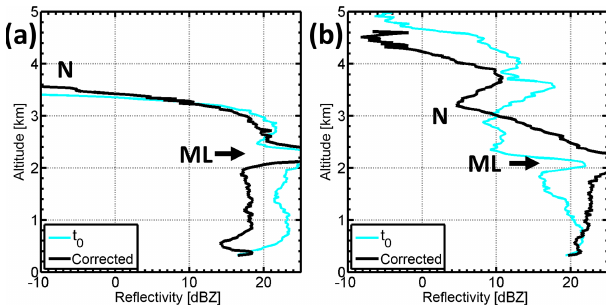
Figure 8. Panels (a, b) show the fall streak corrected profiles of Z . Panel (a) shows the profiles at 10:12:51UTC and (b) at 11:33:31UTC. The black line is the fall streak corrected profile and the light blue line represents the vertical profile at the given time. ML points out the signature of the melting layer and N the signa- ture related to needle growth and new generated particle population,